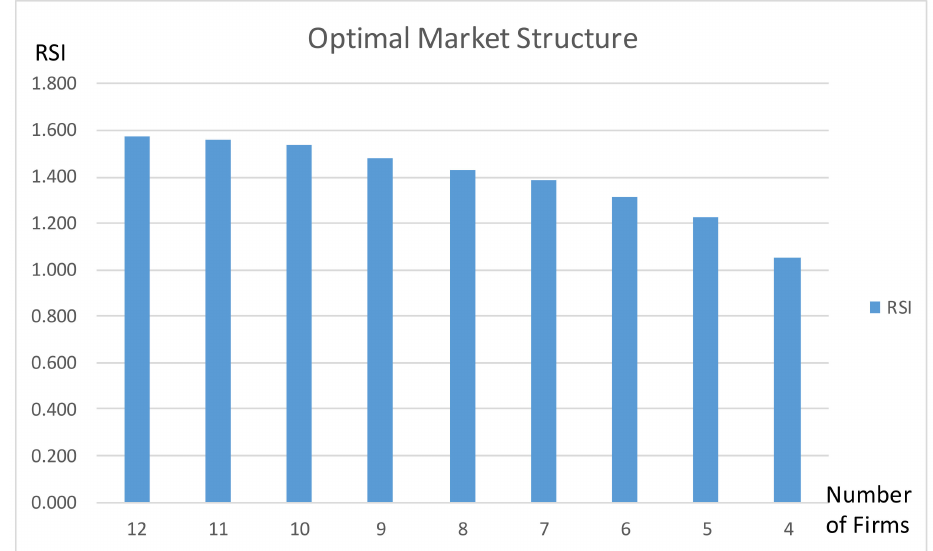
Figure 23. Optimal market structure case 2.